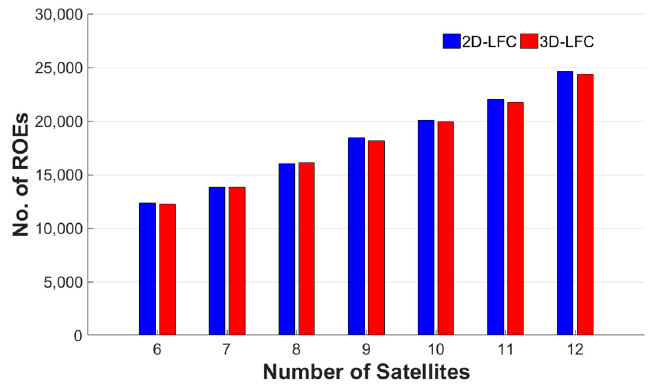
Figure 4. The numbers of ROEs observed in one day by the final optimal LEO constellations with 2D-LFC and 3D-LFC patterns composed of 6–12 satellites.